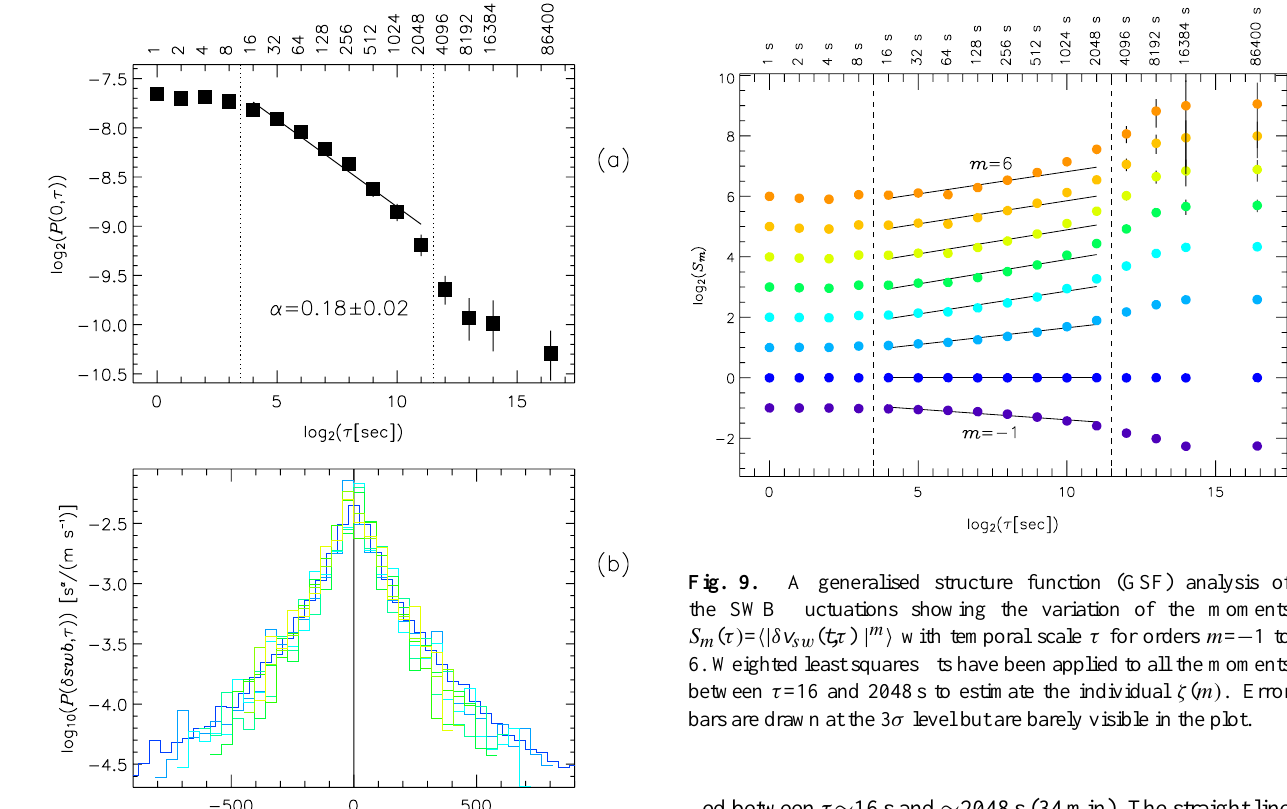
fied between τ ∼ 16 s and ∼ 2048 s (34 min). The straight